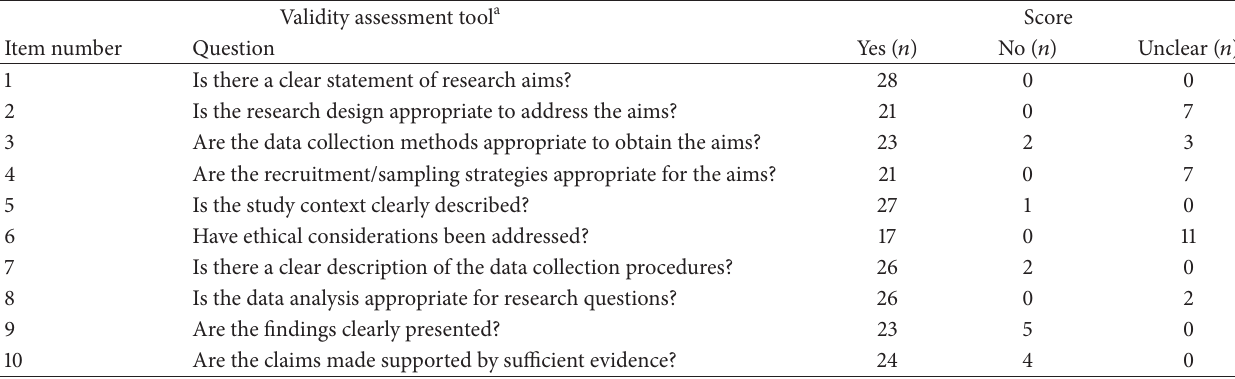
Table 1: Quality of included